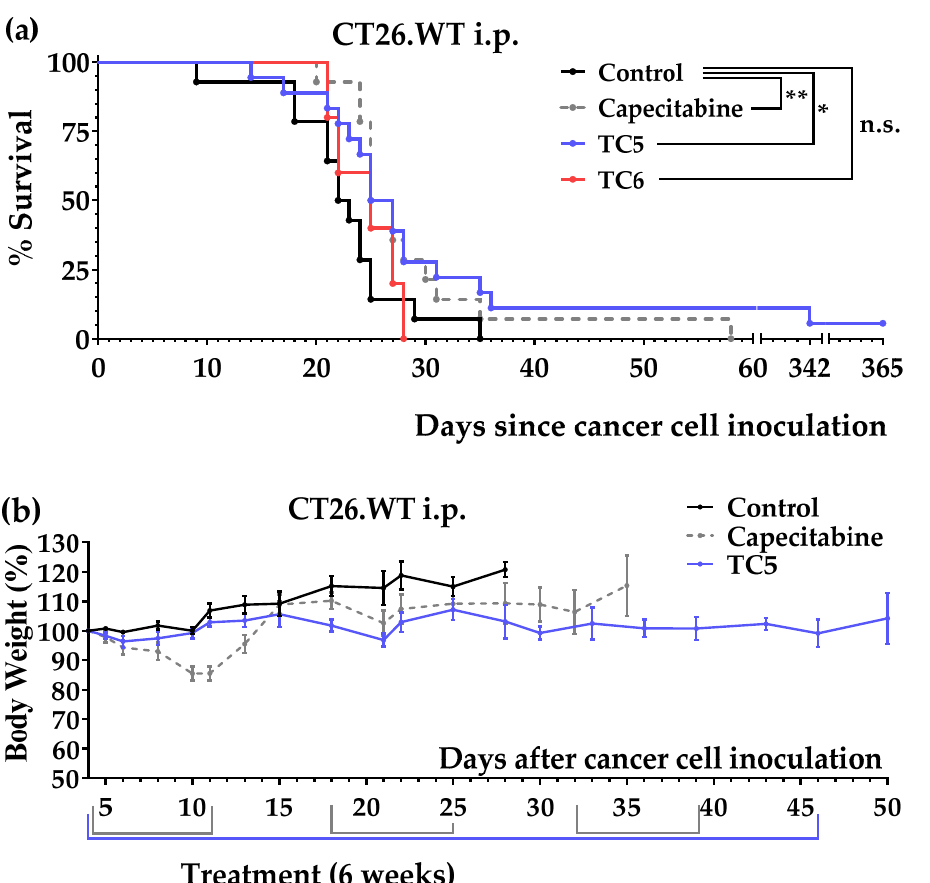
Figure 5. Anticancer effect of diet TC5 and capecitabine in mice with colon cancer (peritoneal dissemination model; CT26.WT murine colon cancer cells inoculated in the peritoneum of immunocompetent BALB/c mice). ( a ) Survival of the mice left untreated (control), treated with diet TC5 (normal diet was replaced by diet TC5 for 6 weeks), with diet TC6, or with oral capecitabine (450 mg/kg/day, 7/7 schedule, 3 cycles). ( b ) Body weights (mean percentage ± SEM) relative to the body weights at the start of the treatments (day 4). The p -values were calculated with the GBW test; * indicates p < 0.05, and ** indicates p < 0.01. n.s. means no